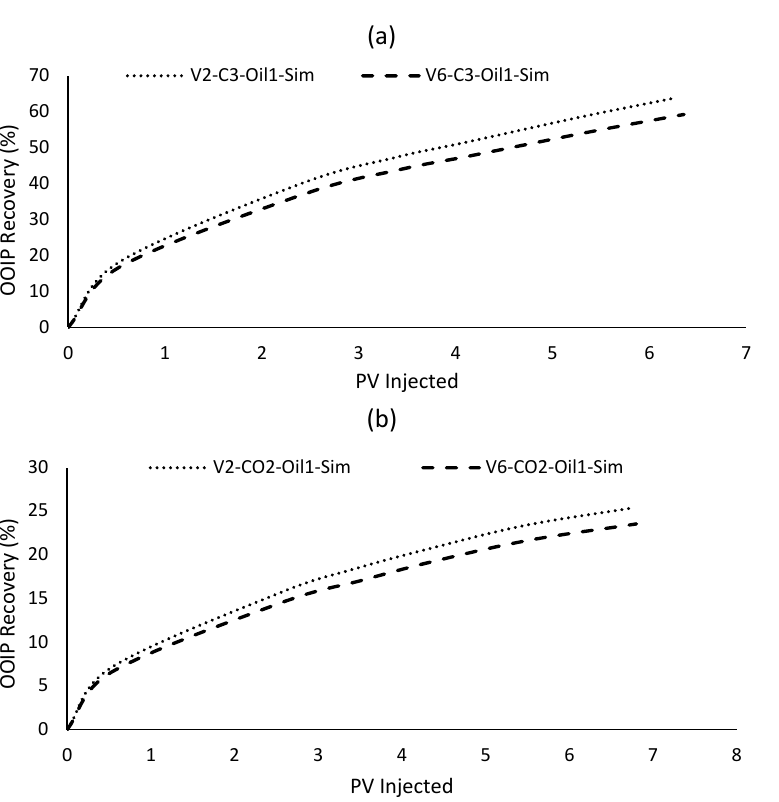
Figure 13. The effect of fracture length on the recovery factors in conventional VAPEX and patterns V2 and V6 using propane ( a ) and carbon dioxide ( b ).